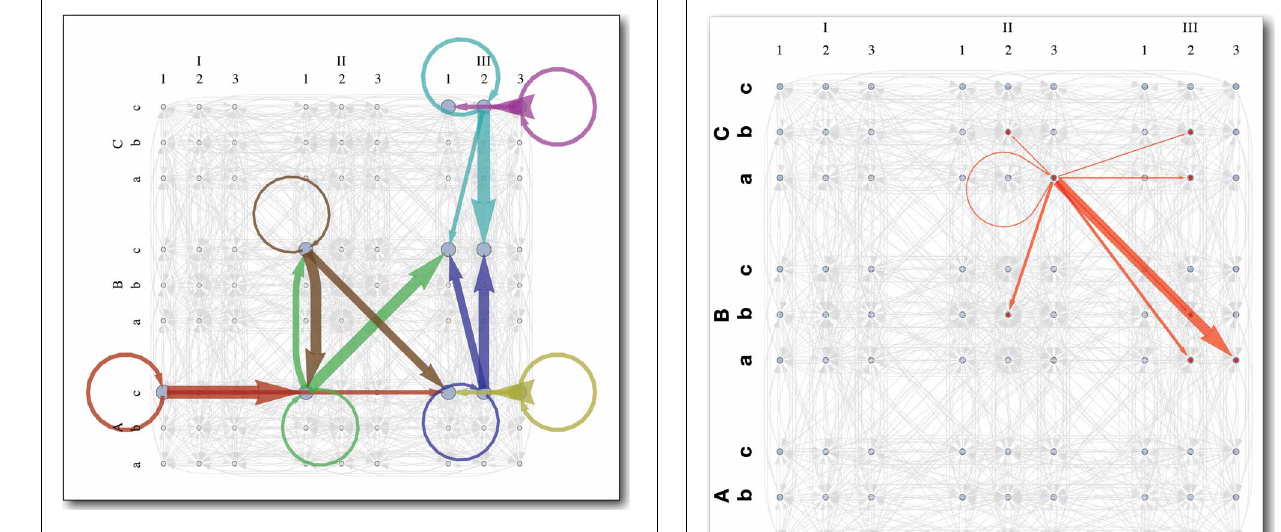
FIGURE 7 | The learned single-arm MDP planner. The 4D state space is labeled as follows: shoulder flexion/extension (1,2,3), arm abduction/adduction (a,b,c), lateral/medial arm rotation (I,II,III), elbow flexion/extension (A,B,C). Each color represents an interesting state-action, which often takes the agent to some unexpected state. Each arrow of a particular color represents a state transition probability and the weight of the arrow is proportional to the magnitude of that probability. Arrows in gray represent boring state-actions. These work as expected, reliably taking the agent to the intended goal state, to which they point.